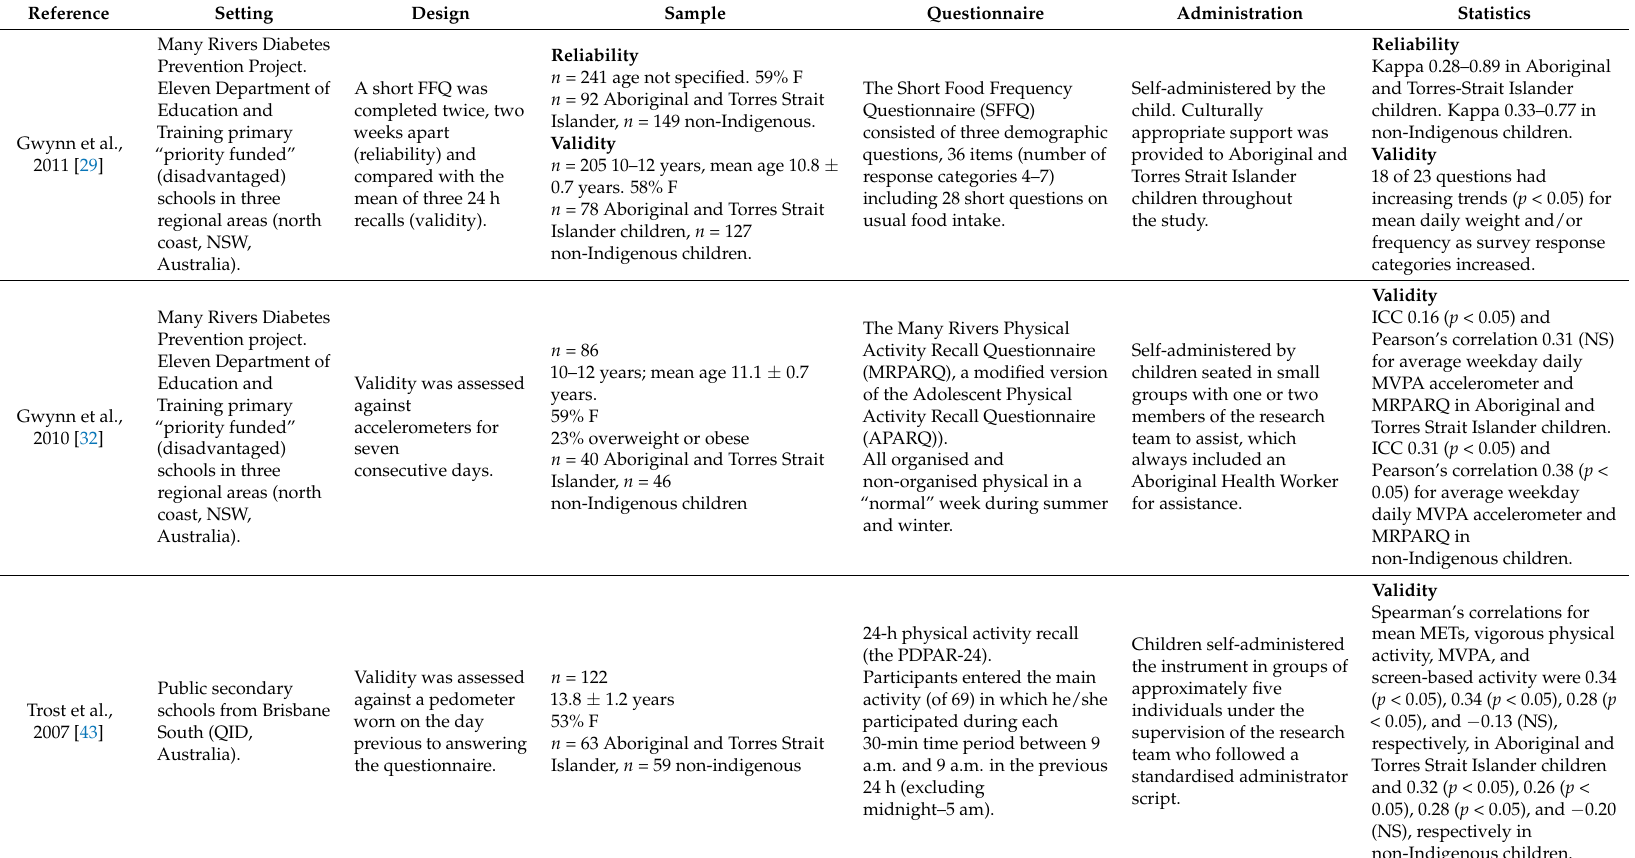
Table 3. Diet, physical activity and sedentary behaviour questionnaires used in Aboriginal and Torres Strait Islander children included in the review from peer-reviewed journal articles